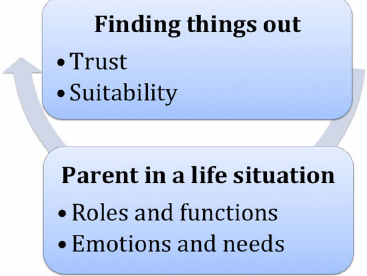
Figure 1. Overview of themes and sub-themes.